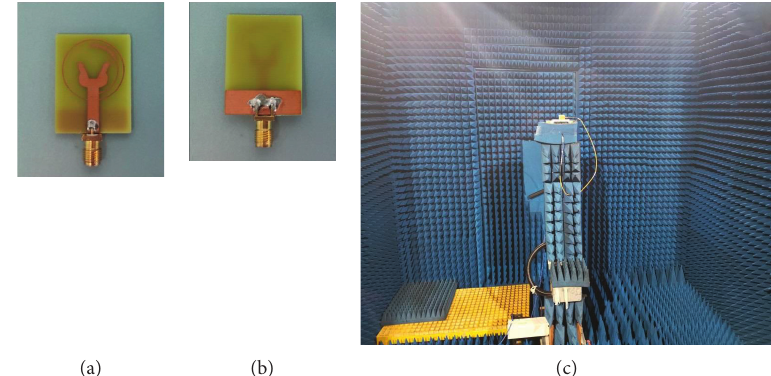
Figure 5: (a) Front and (b) back views of the fabricated antenna prototype. (c) Photograph of the measurement environment.